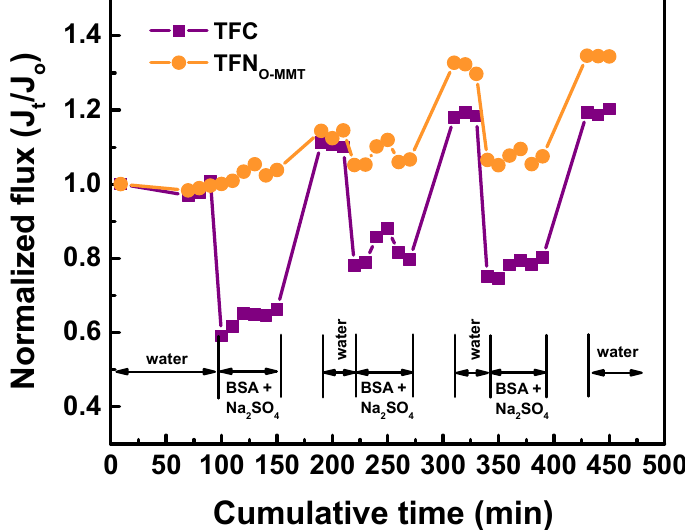
Figure 13. Antifouling property of TFC and TFN O-MMT . Feed = 100 ppm BSA + 1000 ppm Na 2 SO 4 ; Operating condition: pH = 7.4, 6 bar, 30 °C. The normalized flux was calculated as the ratio of flux (J t ) at time t over the initial flux (J o ) measurement.